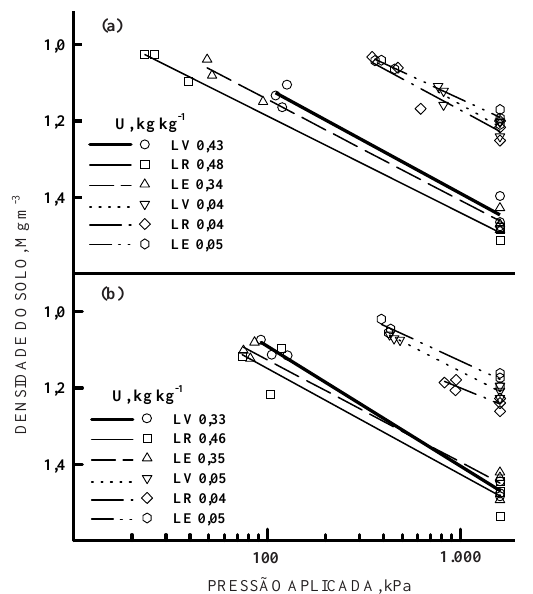
Figura 5. Retas de compressão virgem ajustadas para o Latossolo Vermelho-Amarelo (LV), Latossolo Roxo (LR) e Latossolo Vermelho- Escuro (LE) sob pastagem cultivada, nas profundidades de 0-0,03 (a) e 0,27-0,30 m (b), com a maior e a menor umidade gravimétrica (U) utilizadas (n = 6).